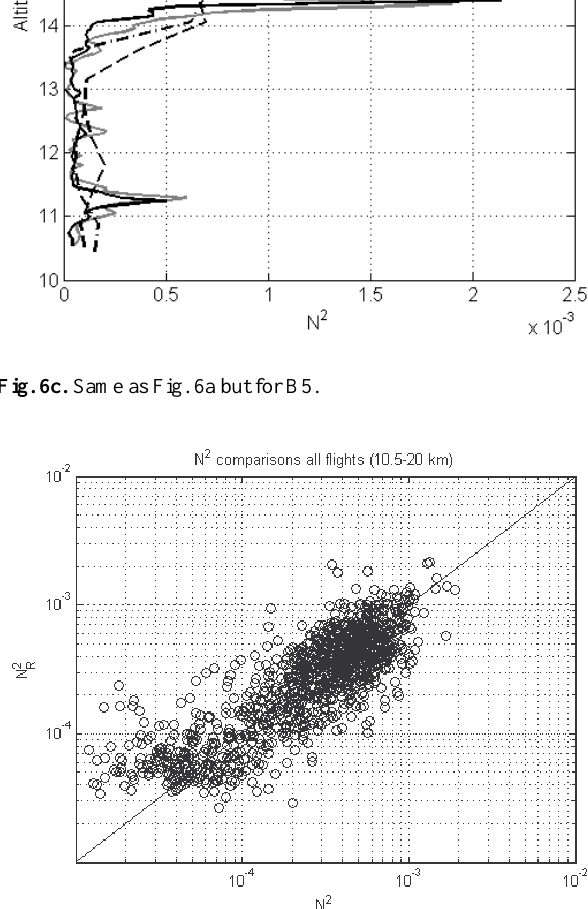
for the 6 balloon flights and b